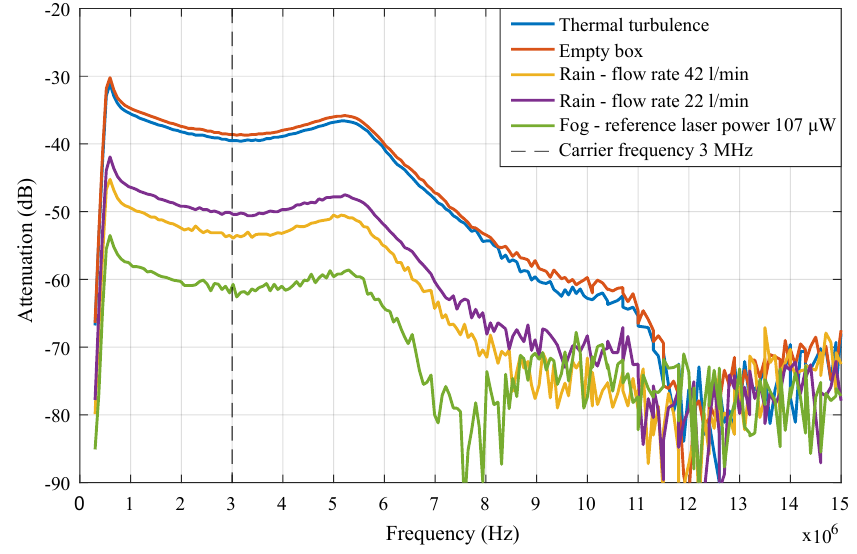
Figure 13. Attenuation characteristics of the Octavia tail-light.